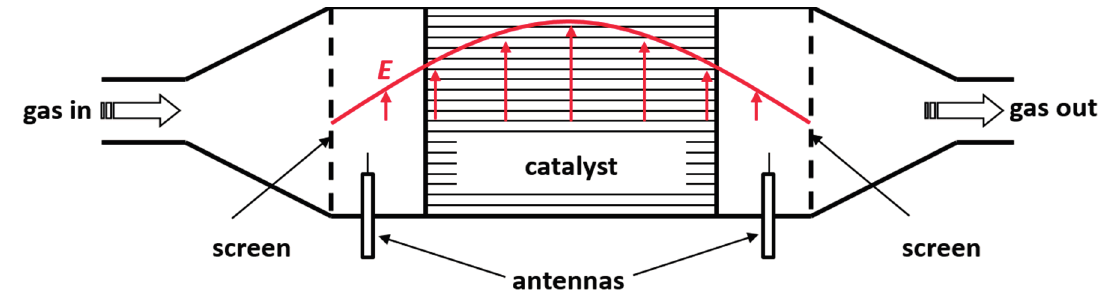
Figure 8. Schematic illustration of the resonator cavity for monitoring of exhaust gas after treatment devices, with antennas and screens up- and downstream of the catalyst or